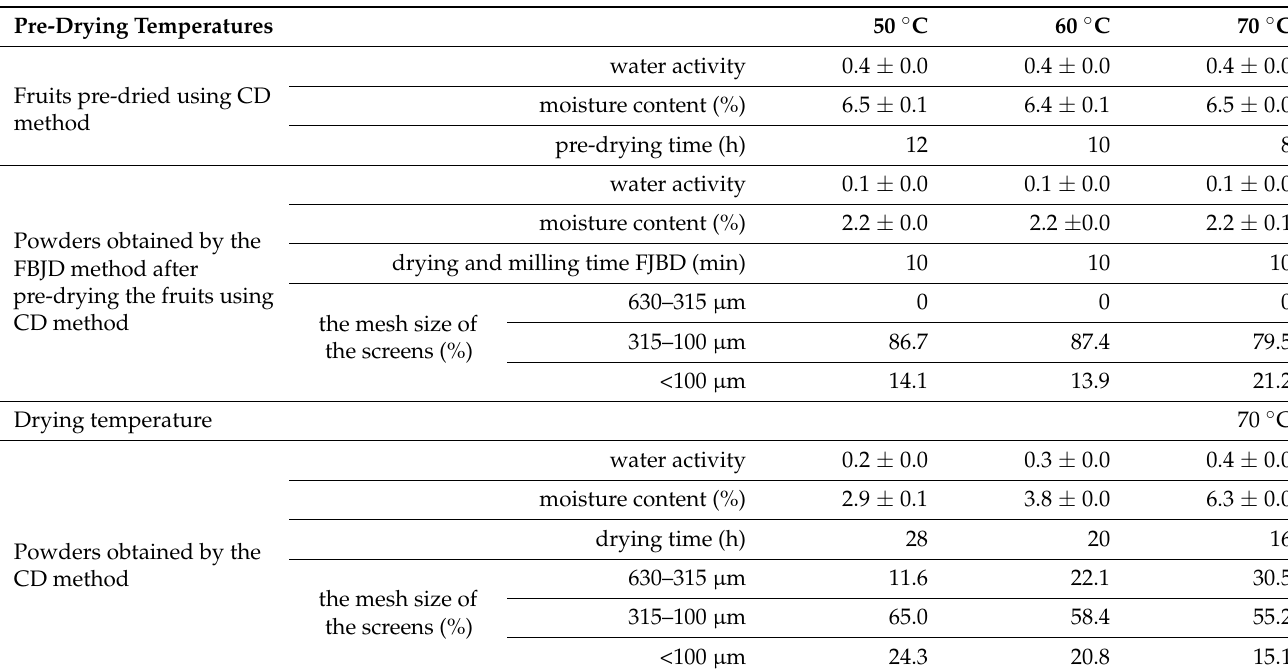
Table 1. Tested samples